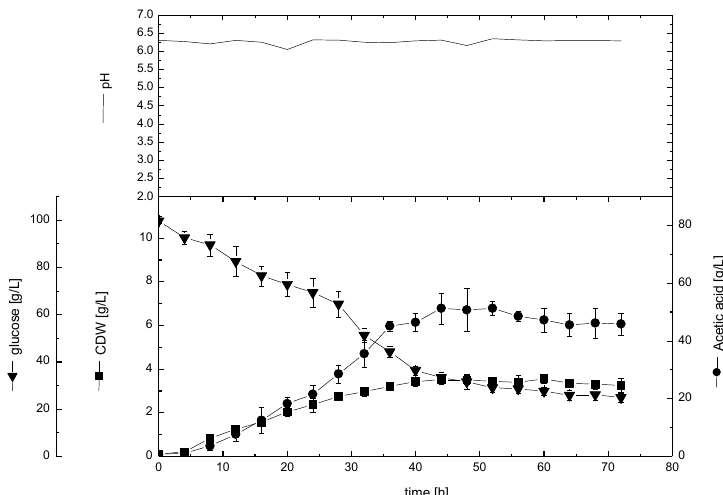
Figure 7. Batch cultivation for acetic acid production using bioreactor 16-L under controlled pH.